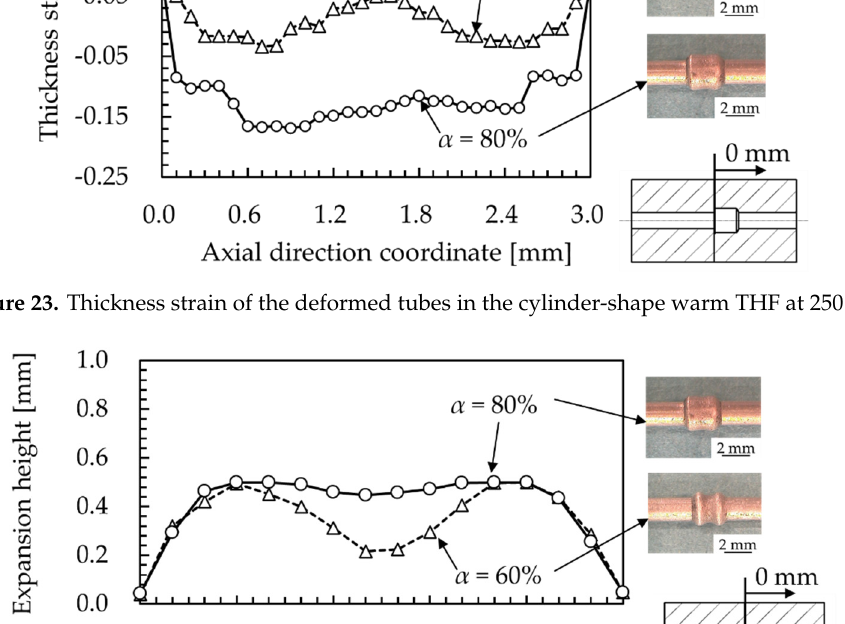
Figure 24. Expansion distribution of the deformed tubes in the cylinder-shape warm THF at 250 °C.